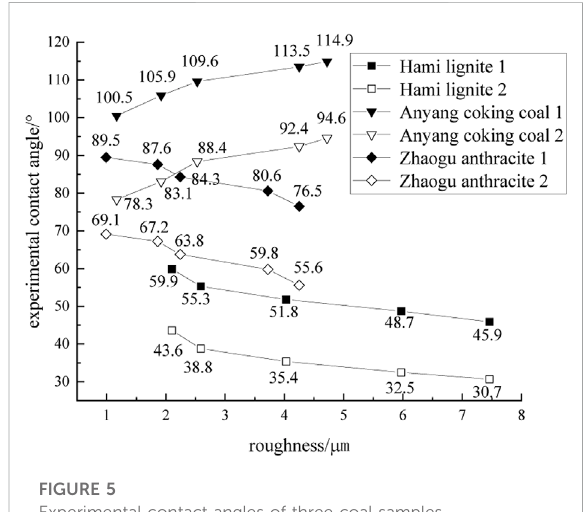
FIGURE 5 Experimental contact angles of three coal